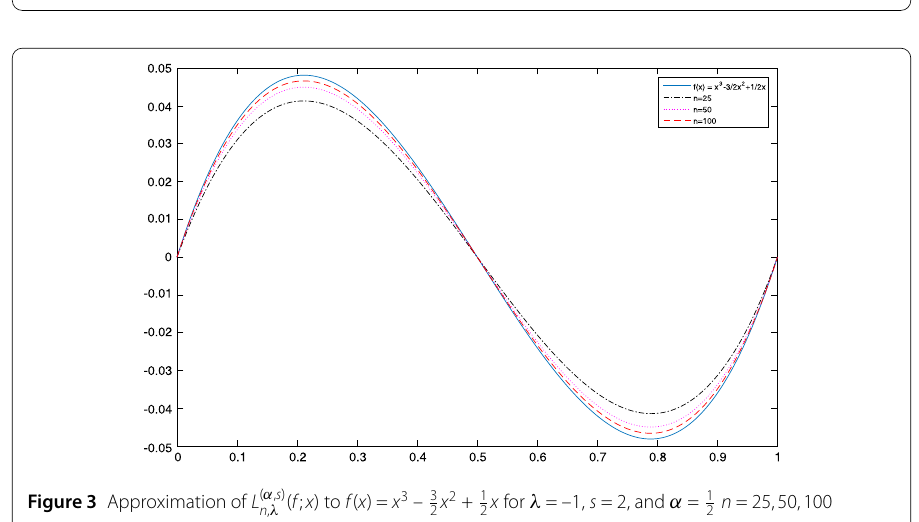
( f ; x ) to f ( x ) = x 3 – 3 n , λ